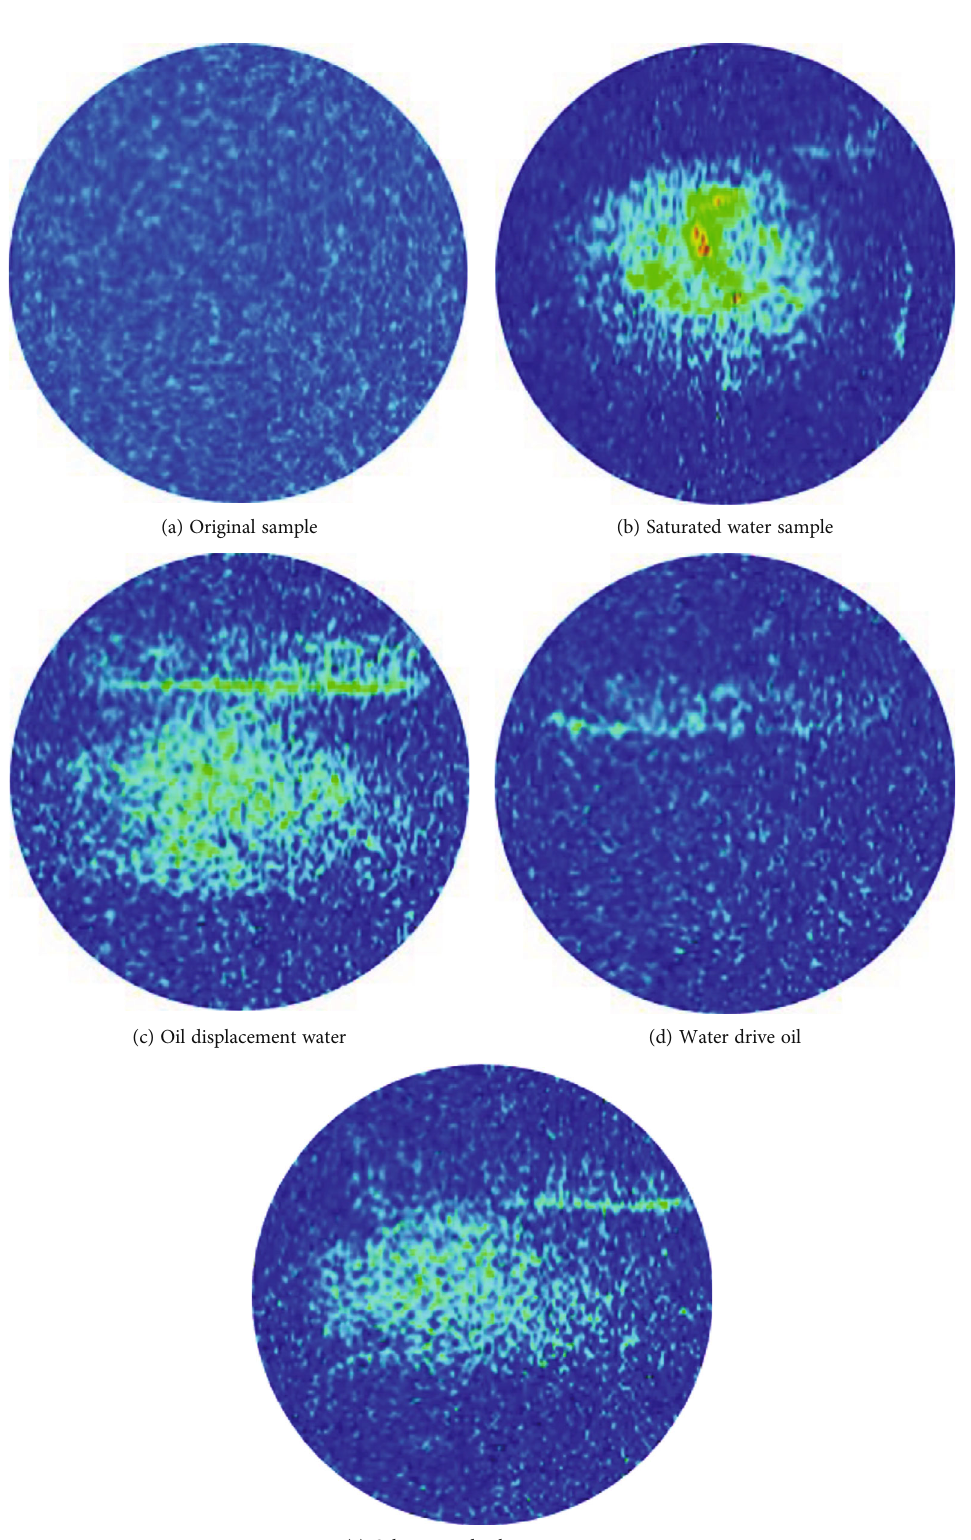
Figure 3: Pseudocolor NMR images of di ff erent stages of core slice